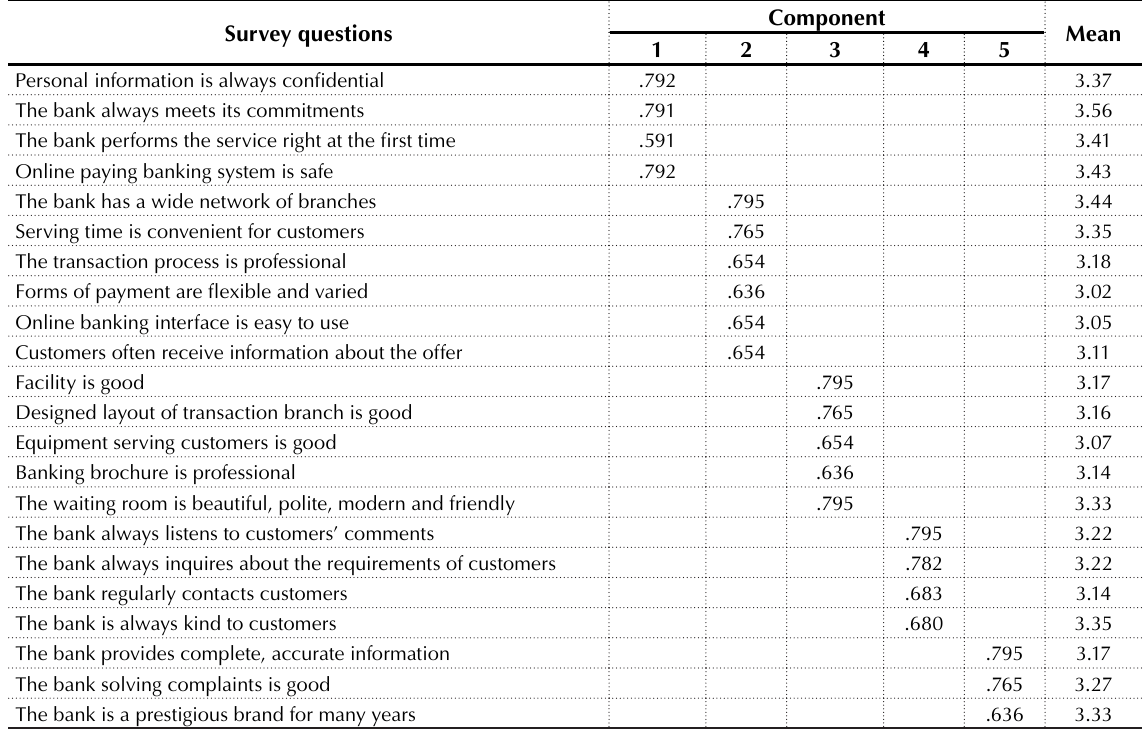
Table 3. Rotated component matrix a